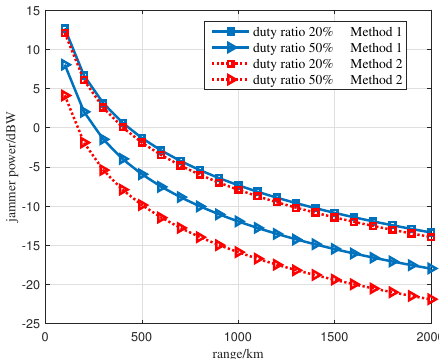
Figure 3. Required jammer power of two